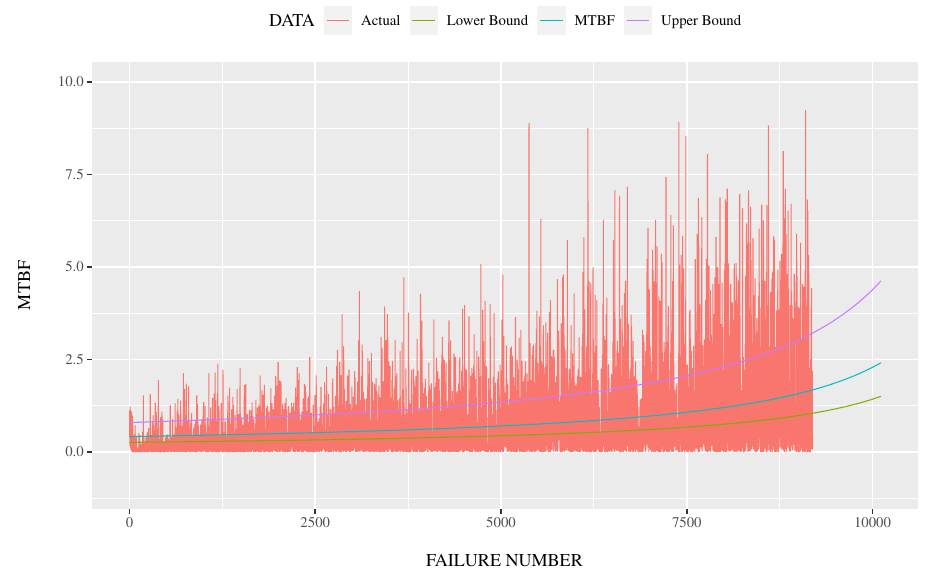
Figure 6. The estimated upper and lower confidence limits for the MTBF c in actual fault big